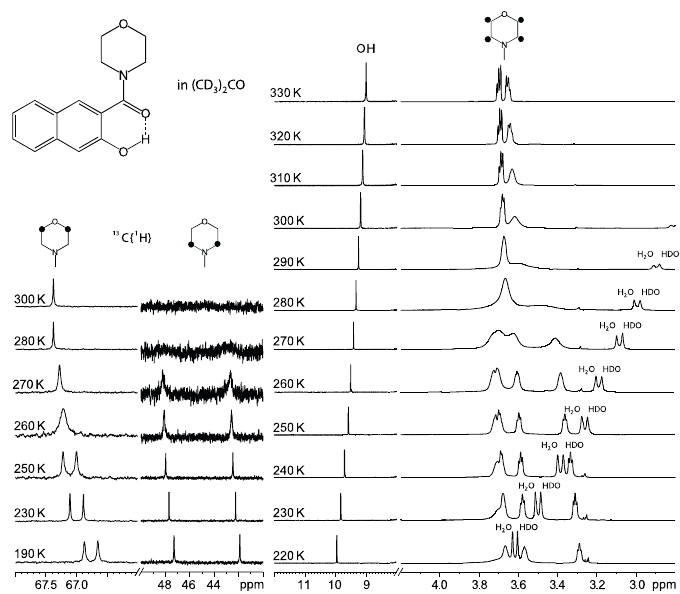
Catalysts 2019 , 9 , x FOR PEER REVIEW 10 of 18 Figure 15. The 1 H and 13 C NMR spectra β -hydroxy naphthalene amide derivative as a function of temperature in (CD 3 ) 2 CO. Reprinted from Ref [68]. Copyright 2015, Elsevier.